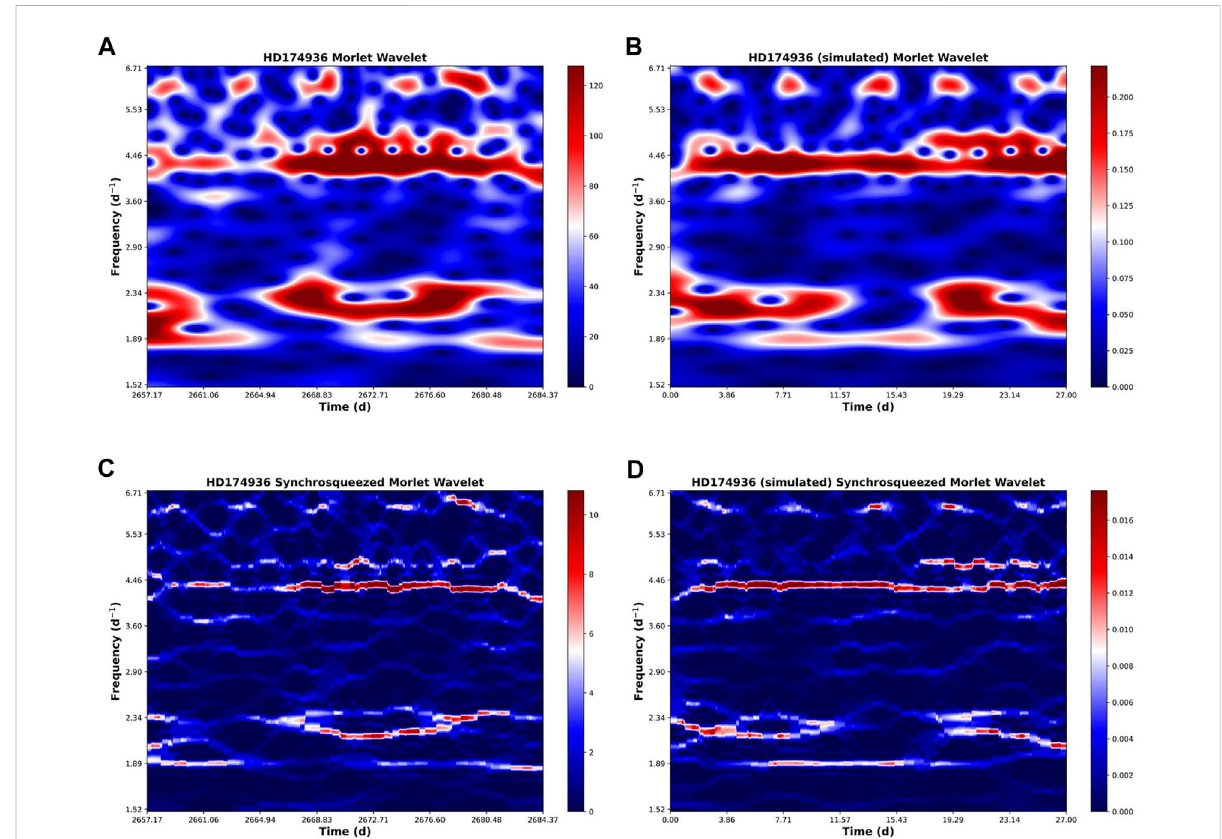
FIGURE 3 Frequencies of HD174936 between 1.52 d − 1 and 6.71 d − 1 . The CWT (panels A and B) of the group of frequencies between 1.89 d − 1 and 2.34 d − 1 shows some overlapping in the coef fi cients (red zones) and this can be hampering the synchrosqueeze algorithm. Hence the apparent instability of these frequencies in the SSWCT (panels C and D). The same could be happening between the frequency at 4.46 d − 1 and a slightly higher one around 4.8 d − 1 . In the frequency at 4.46 d − 1 , the SSWCT of the synthetic curve shows an almost straight and continuous band along the temporal axis whereas in the signal from the star the band seems to be weaker in the fi rst 8-10 days of observation, which could be a sign of an instability of some kind in this